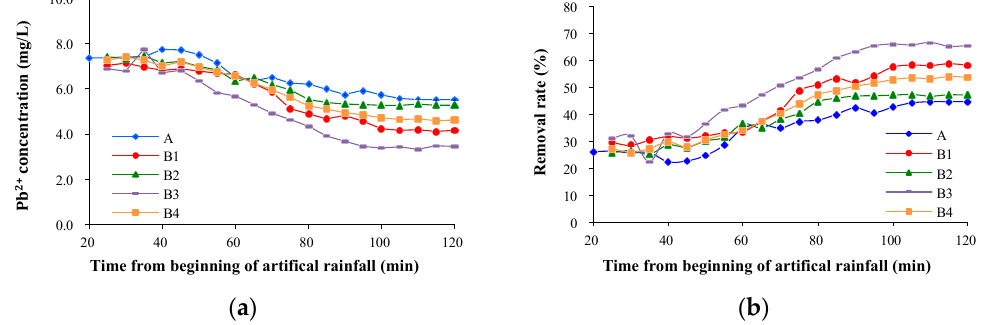
Figure 4. Results of the first artificial rainfall event: ( a ) Graph of Pb 2+ concentration versus time for the PA systems providing direct stormwater drainage during the first artificial rainfall event; and, ( b ) Graph of Pb 2+ removal rate versus time for the PA systems providing direct stormwater drainage during the first rainfall event.